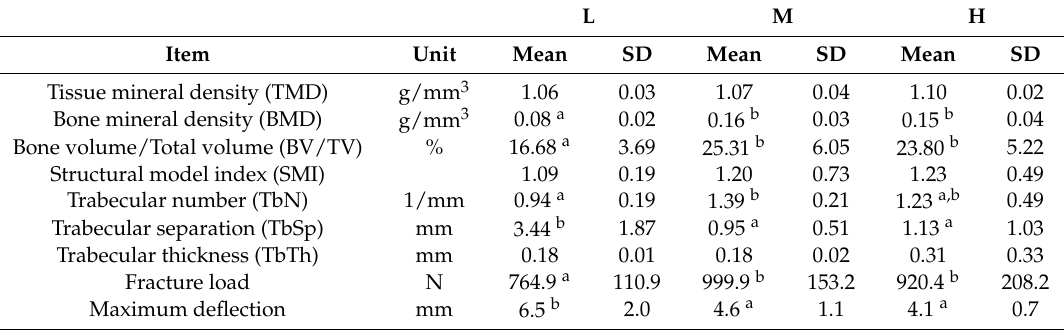
Table 1. Densiometric and morphometric characteristics of femurs excised from 64-day-old piglets fed variable dietary amounts of P and